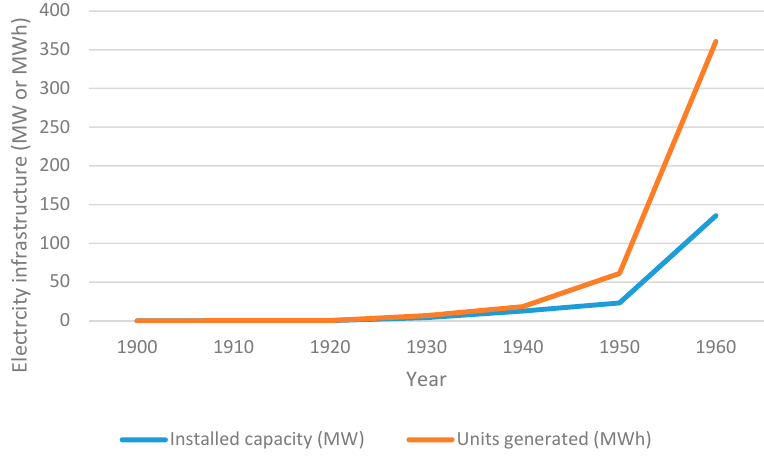
Figure 3. Electricity infrastructure growth in Nigeria across 1900–1960 in Mega Watts (MW) or Mega Watt hours (MWh) [22].